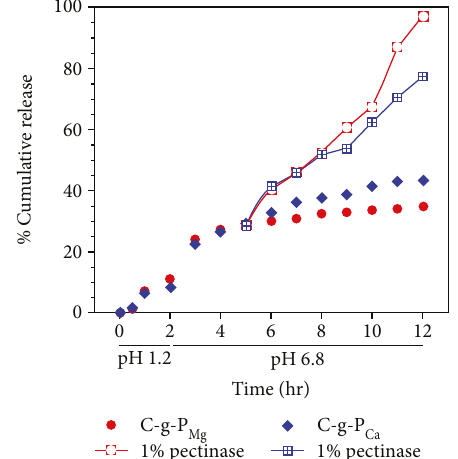
Figure 5: Curcumin release (%) for C-g-P C-g-P ( fi lled rhombus) prepared by method A in the absence Ca of pectinase. Curcumin release for C-g-P for C-g-P (crossed square) in the presence of pectinase from Ca the 6th hr.